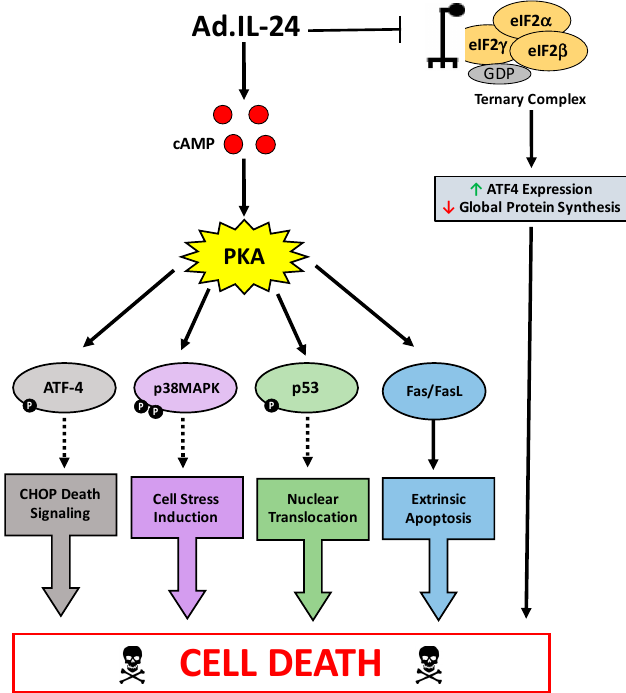
Figure 6. IL-24 activates PKA to induce apoptosis in breast cancer cells. A schematic of the molecular mechanisms underlying Ad.IL-24 induced apoptosis of cancer cells, involving PKA activation, ATF-4 phosphorylation, p38MAPK signaling, p53 phosphorylation, Fas apoptotic signaling, and the inhibition of translation initiation (red arrow indicates downregulation; green arrow indicates upregulation; black arrows indicate pathway activation, black dotted arrows indicate potential mechanism of action, black bar headed arrow indicates inhibition) .